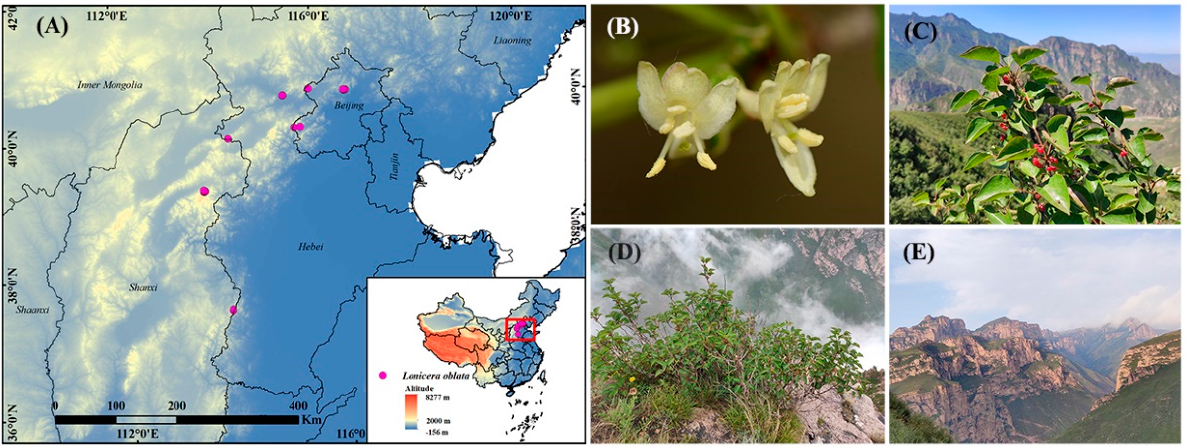
Figure 1. Photos of Lonicera oblata in the field and its distribution. ( A ) location; ( B ) flower; ( C ) fruit; ( D ) individual; ( E ) habitat.